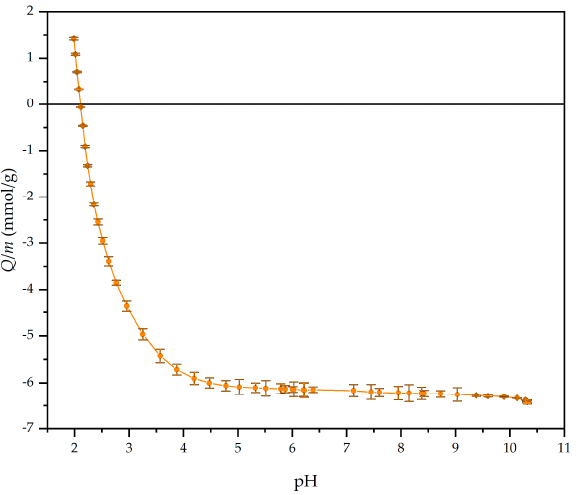
Figure 1. Potentiometric titration curve for HA with a charge per mass as a function of pH. Results of HA adsorption as the second layer monitored by QCM-D revealed similar behavior for both Au-PDMS/Chi-77KS and Au-PDMS/Chi-77KS/AMOX (Figure 2), as the frequency shift after 1 h for both samples decreased ( ∆ f = − 700 Hz). After the rinsing step using 150 mM NaCl, frequency increased to ∆ f = − 370 Hz for Au-PDMS/Chi-77KS and to ∆ f = − 420 Hz for Au-PDMS/Chi-77KS/AMOX. The enormous change in frequency and dissipation might be explained by the fact that HA can absorb an immense amount of water and expand up to 1000-fold of its solid volume, forming a loose hydrated network [44]. Nevertheless, the increase in ∆ f for both Au-PDMS/Chi-77KS/HA and Au-PDMS/Chi- 77KS/AMOX/HA might also be explained by the effect of NaCl, altering density and packing HA molecules closer to the surface through charge screening. The latter was ob- served with ∆ D decreasing from an initial 175 to 125 × 10 − 6 for Au-PDMS/Chi-77KS/HA and 120 to 85 × 10 − 6 for Au-PDMS/Chi-77KS/AMOX/HA after the NaCl rinsing step (Figure 2b). In the presence of NaCl, HA may adopt a coil-like structure on the surface, as repulsion forces between HA charges are reduced, leading to increased ∆ f and decreased ∆ D